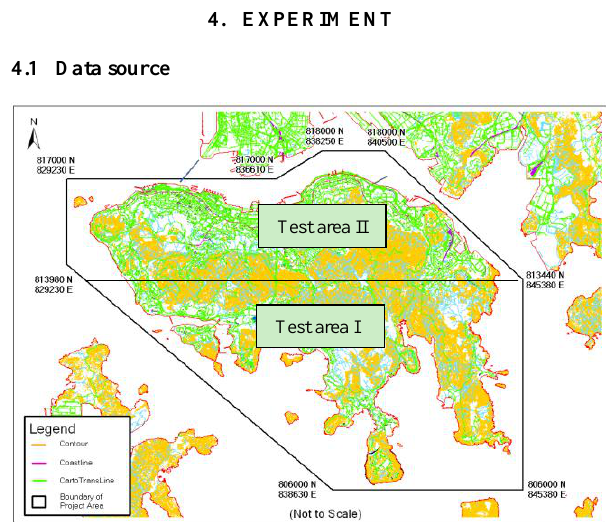
Figure 3. Boundary of the research area. The test area I is located in the south of Hong Kong Island, the test area II is located in the north of Hong Kong